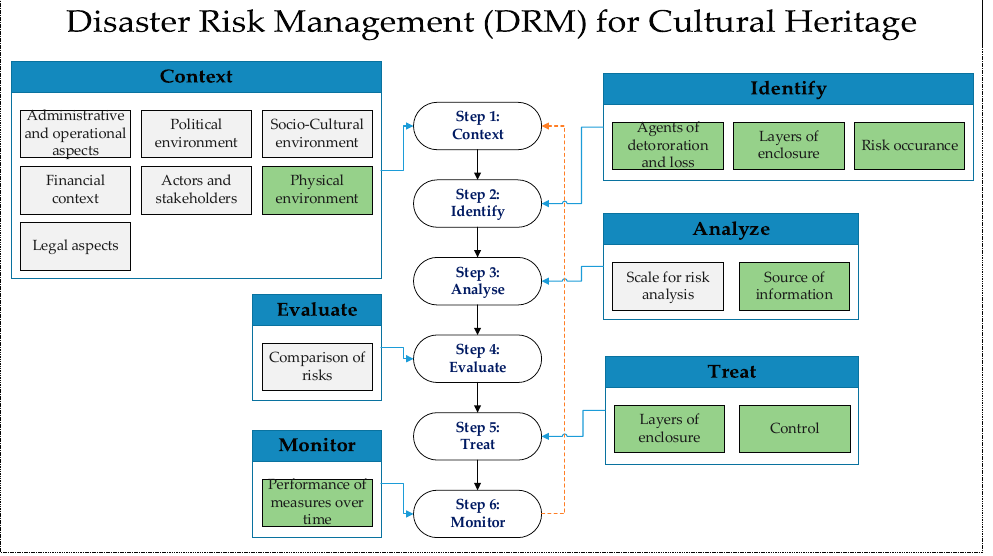
Figure 4. The potential contribution of satellite observation within the various steps of the risk management plan proposed by the International Centre for the Study of the Preservation and Restoration of Cultural Property (ICCROM) [17] is highlighted in the green rectangle.